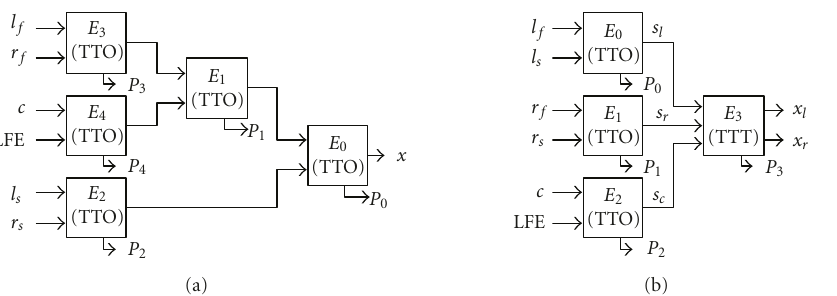
Figure 2: Two encoder tree configurations for 6-channel input and a mono downmix (left panel) or a stereo downmix (right panel). Each block ( E i ) represents a TTO or TTT encoding block and generates a set of parameters ( P i ).